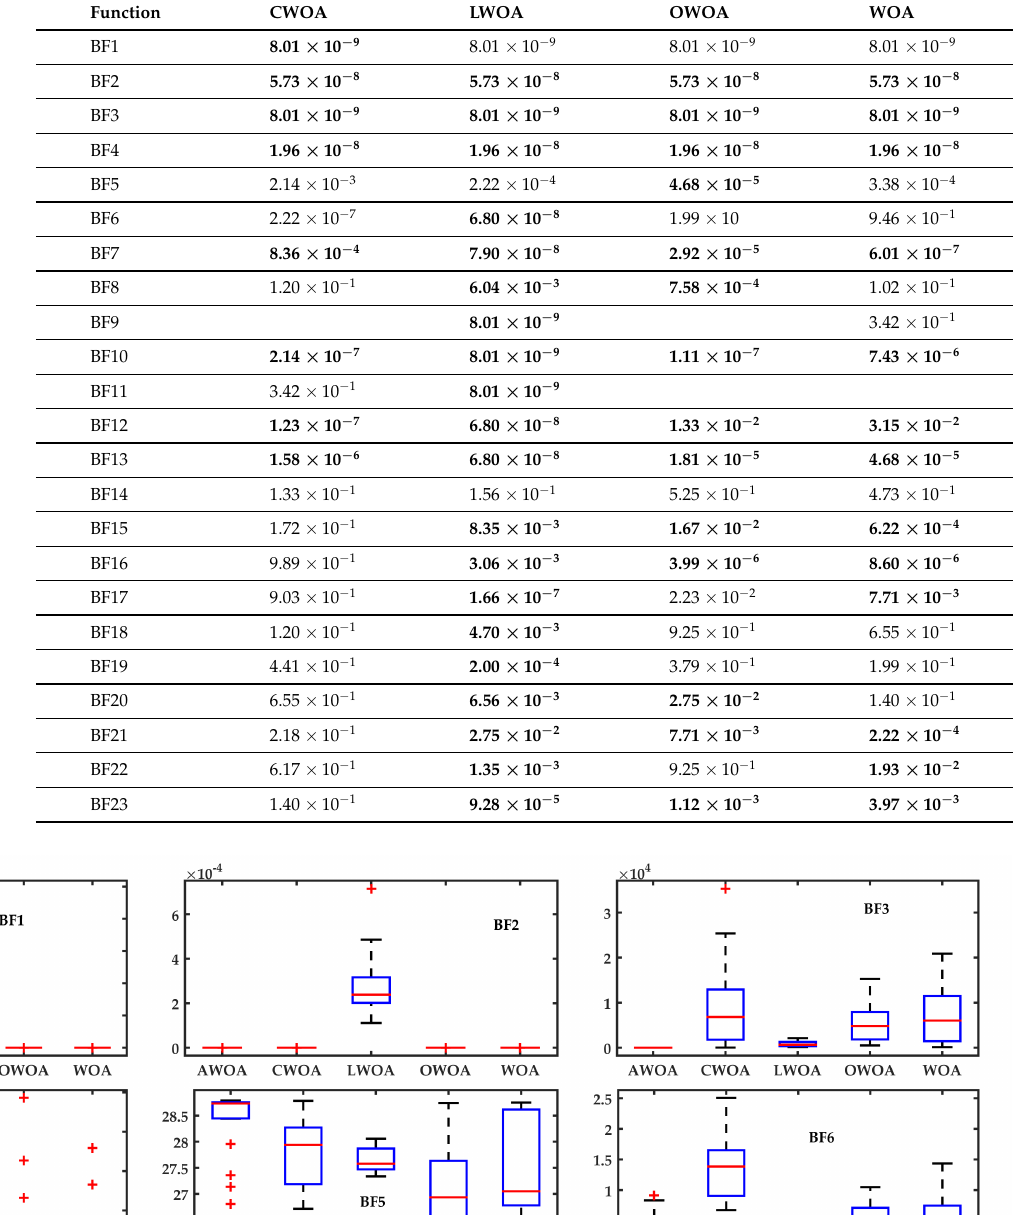
Table 4. Results of Wilcoxon rank sum test of AWOA.